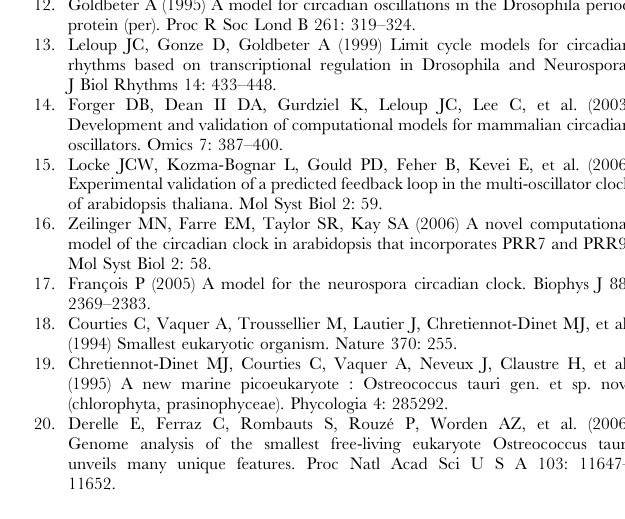
different levels of coupling strength (blue: p/p 0 =1.17; cyan: p/p 0 =2; red: p/p 0 =0.85; orange: p/p 0 =0.5; p/p 0 being the ratio between the parameter values within and outside the coupling window. Figure S5 Resetting of the clock model of Fig. 4 in response to a phase shift of the day/night cycle. Solid curves display the residual phase shift of the clock after 1 (black) and 5 (blue) day/night cycles as a function of the initial phase shift. (A) TOC1 degradation rate is multiplied by 2.1 between ZT0 and ZT6.5. (B) CCA1 degradation rate is multiplied by 0.6 between ZT12.8 and ZT13.95. (C) Figure 6C is reproduced here for convenience. TOC1 (resp. CCA1) is multiplied by 2.1 (resp. 0.6) between ZT0 and ZT6.5 (resp. ZT12.8 and ZT13.95), which results in uniform convergence to phase-locking. Phase RMS error after 5 day/night cycles is 25 , min while the maximum error is 1 , hour. Found at: doi:10.1371/journal.pcbi.1000990.s005 (0.03 MB PDF) Figure S6 Response of the fully coupled and occasionally coupled clock models to fluctuations in daylight intensity occurring on a time scale of one hour. The figure is otherwise similar to Fig 8. Found at: doi:10.1371/journal.pcbi.1000990.s006 (0.03 MB PDF) Figure S7 Response of the two occasionally coupled clock models of Fig. , 8 to fluctuations in daylight intensity. (a) Light intensity varying randomly from day to day. The time evolution of TOC1 protein concentration is shown for: (b) the clock model with a FRP of 23.5h; (c) the clock model with a FRP of 25h. The figure is otherwise similar to Fig , 8. Found at: doi:10.1371/journal.pcbi.1000990.s007 (0.06 MB PDF) Text S1 Characterization of gated coupling mechanisms in the weak modulation limit. Found at: doi:10.1371/journal.pcbi.1000990.s008 (0.07 MB